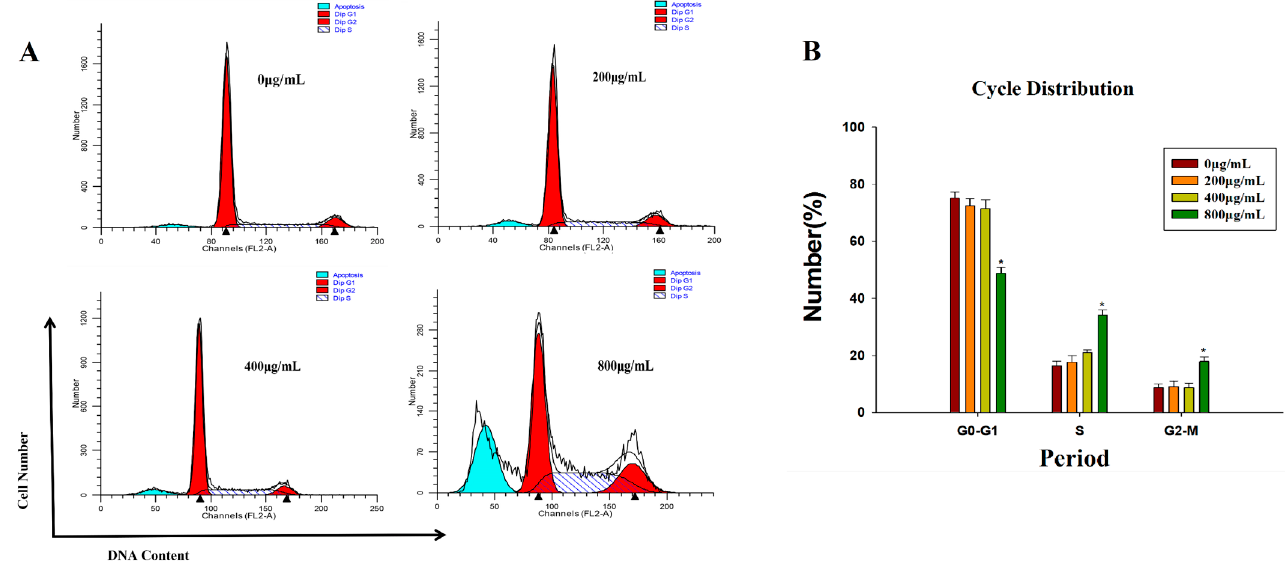
Figure 6. Cell cycle proportions of HepG2 cells treated with DLP120 for 24 h. ( A ) Bar graph summarizes the data on cell cycle distribution. ( B ) * p < 0.05 vs.